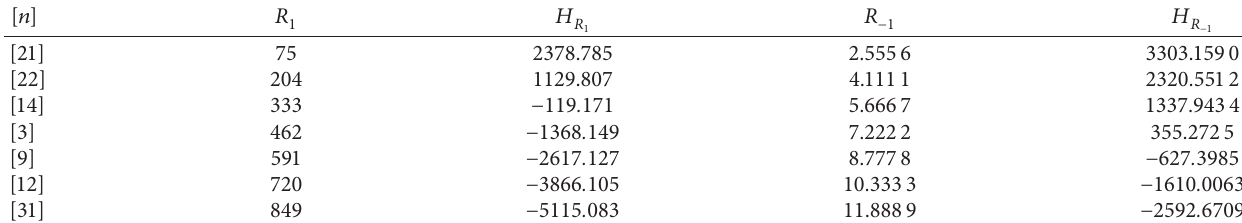
and R − with their respective heat of formation for GST − SL [ n ] . 1 1